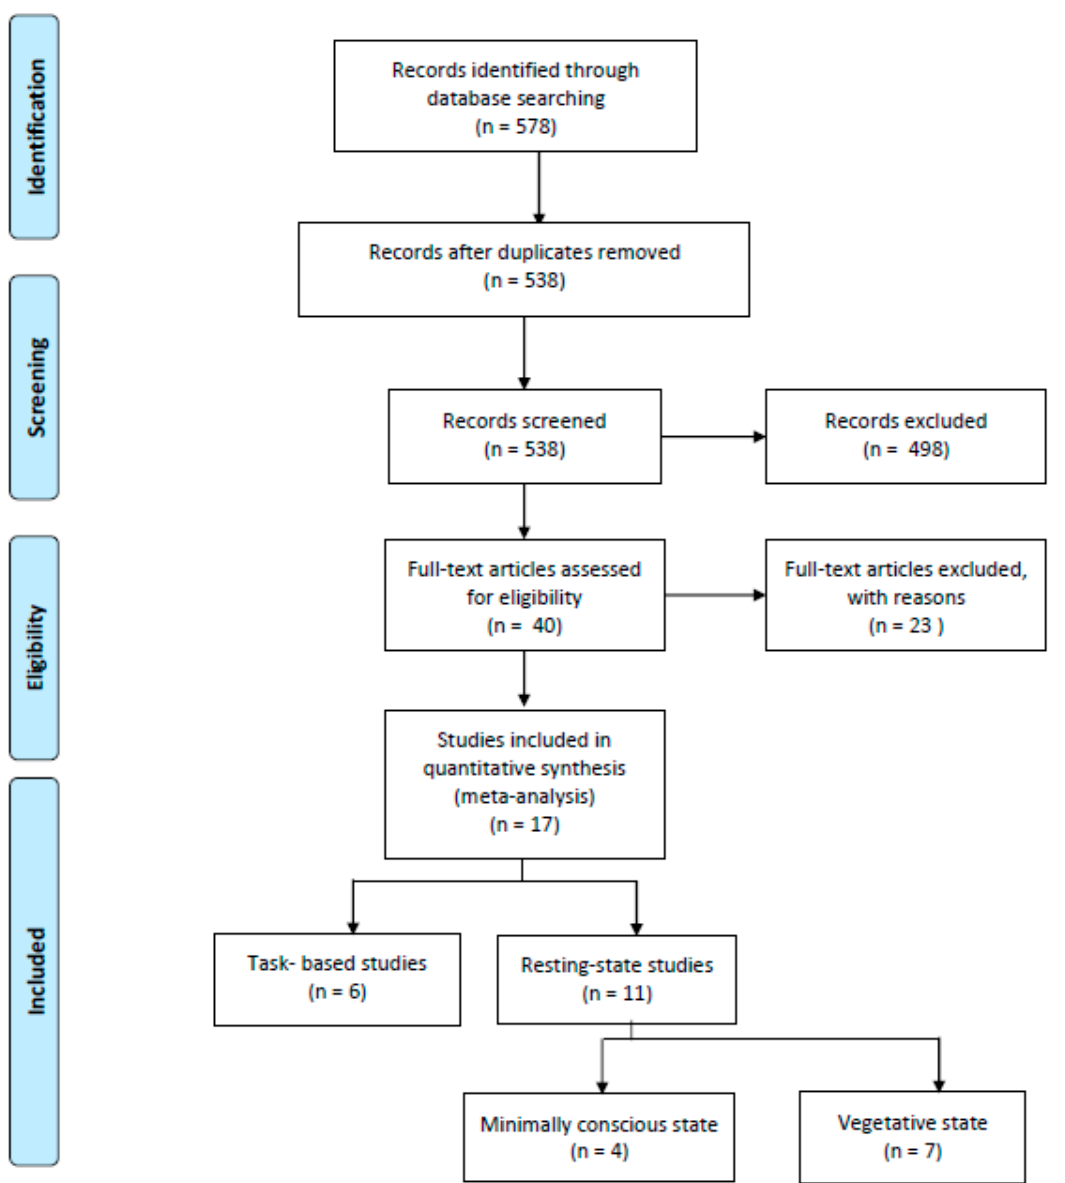
Figure 1. Literature search for the identification of relevant publications included in the ALE (activation likelihood estimate) meta-analysis (from [59]).